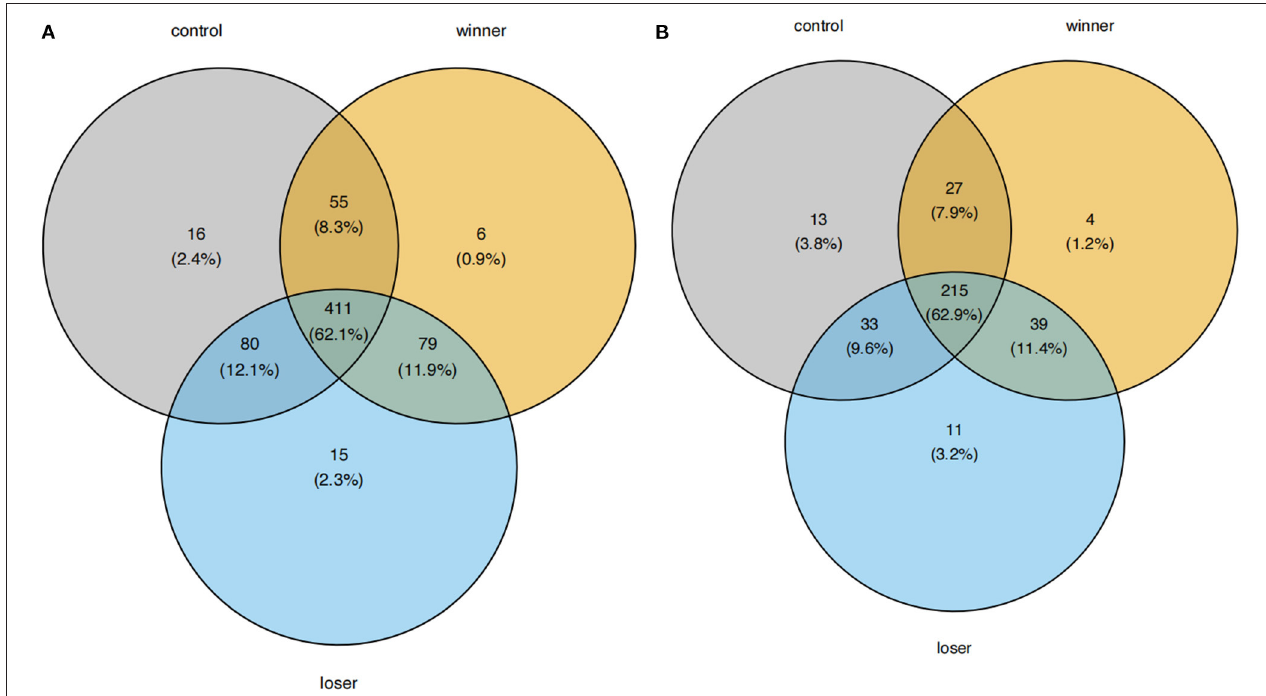
FIGURE 2 | Venn plots showing the comparison of A-to-I RNA editing sites and edited genes among controls, winners, and losers. (A) A-to-I RNA editing sites and (B) edited genes are shown, respectively.